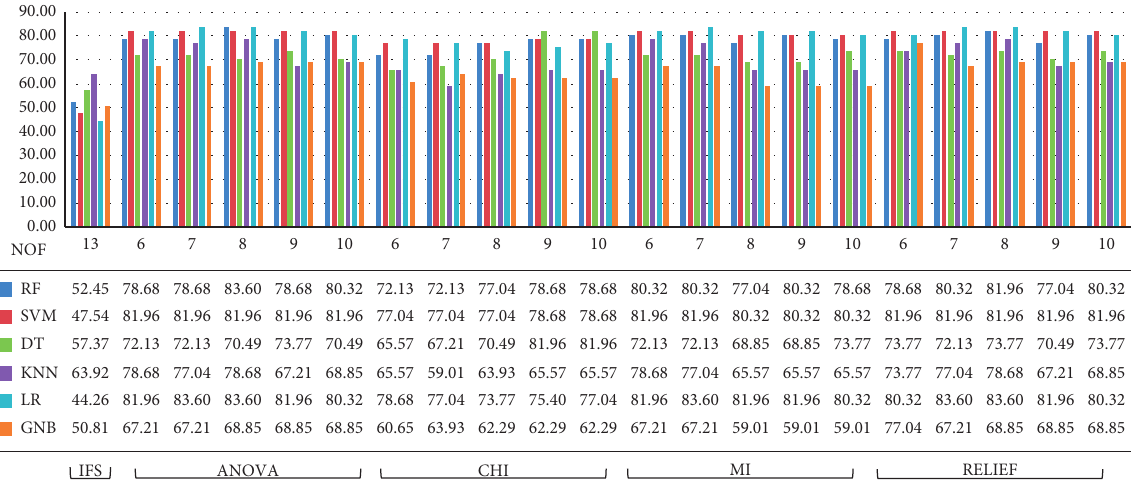
Figure 4: Classification accuracies of reduced feature subsets using filter-based methods with RF, SVM, DT, KNN, LR, and GNB (NOF: number of features, IFS: initial feature set, ANOVA: ANOVA method, CHI: Chi-square, MI: mutual information, RELIEF: Relief